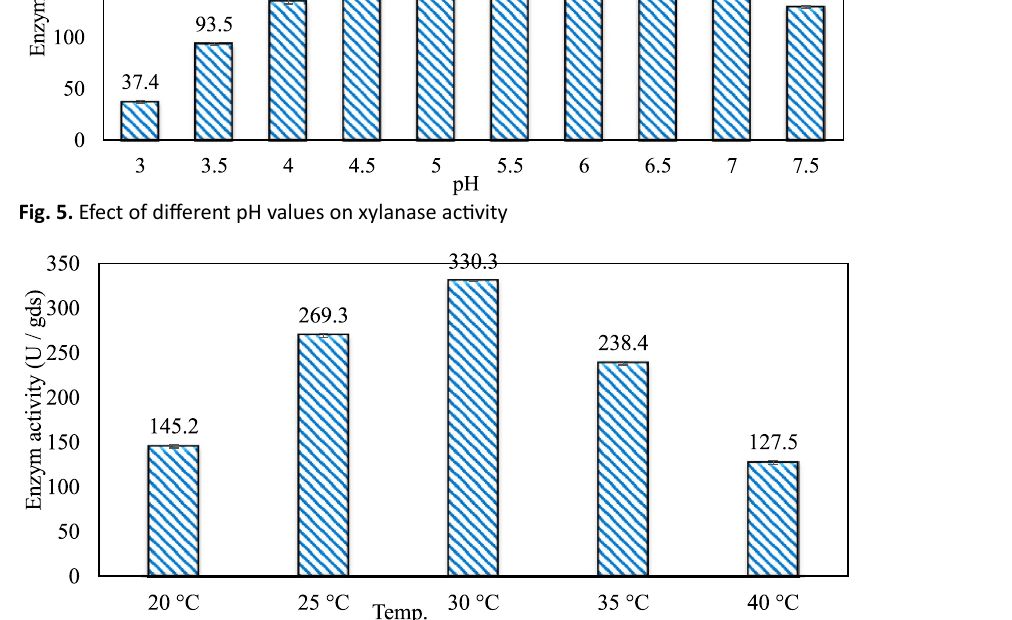
Fig. 6. Effect of different incubation temperatutres on xylanase activity